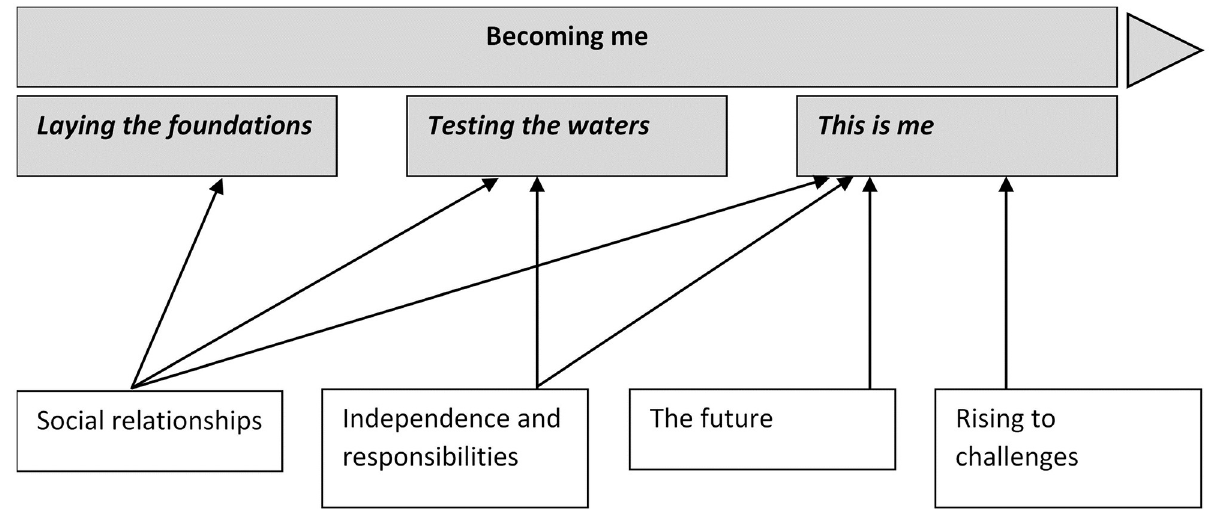
Fig 1. Thematic map. Shaded boxes denote higher-order themes (higher level of abstraction than the original emergent themes). White boxes present themes.